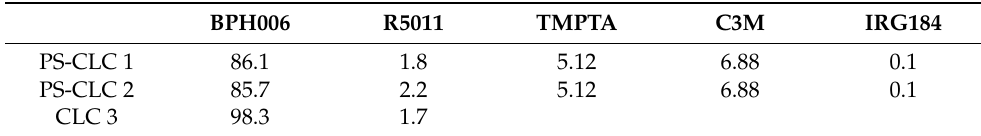
Table 3. Composition ratio of bandwidth tunable LC filter (wt